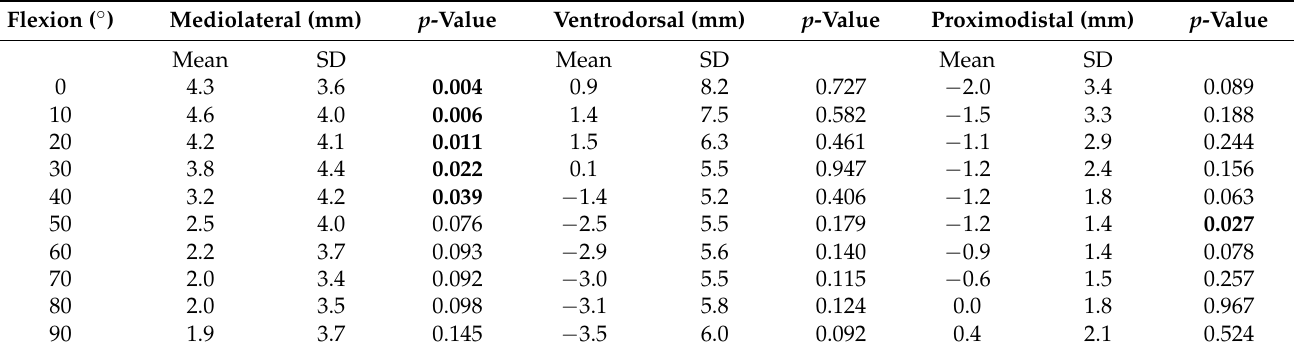
Table 1. Relative shift in the medial epicondyle after total knee arthroplasty (TKA). Relative shifts in the medial epicondyle (mediolaterally, ventrodorsally and proximodistally) after TKA are shown in millimetres (means with standard deviations (SD)) every 10 ◦ of flexion. Positive values show a lateral, dorsal, and distal shift in the epicondyle. Bold characters mark significant differences ( p < 0.05).